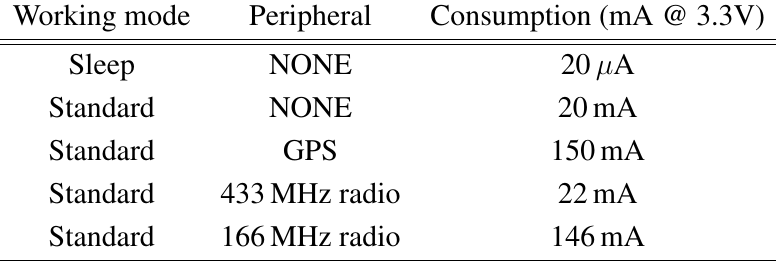
Table 1. Consumption characteristics of the primary